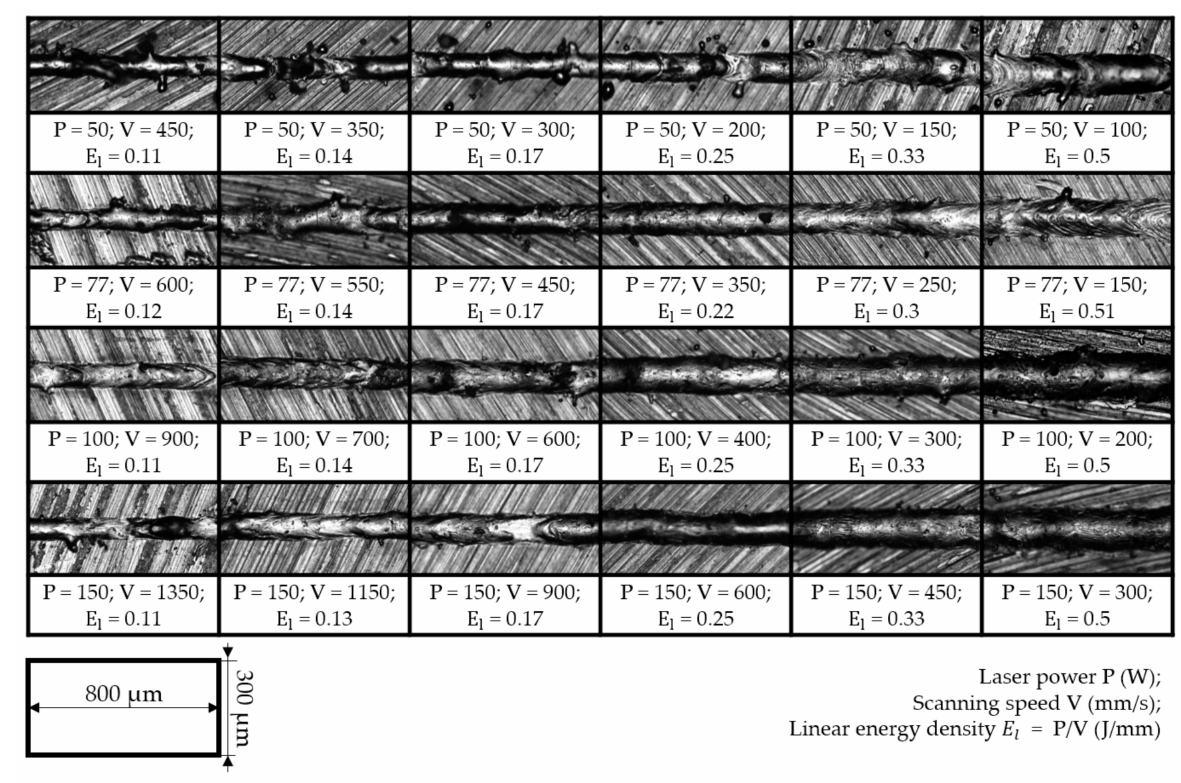
Figure 6. Micrographs of the single tracks’ top